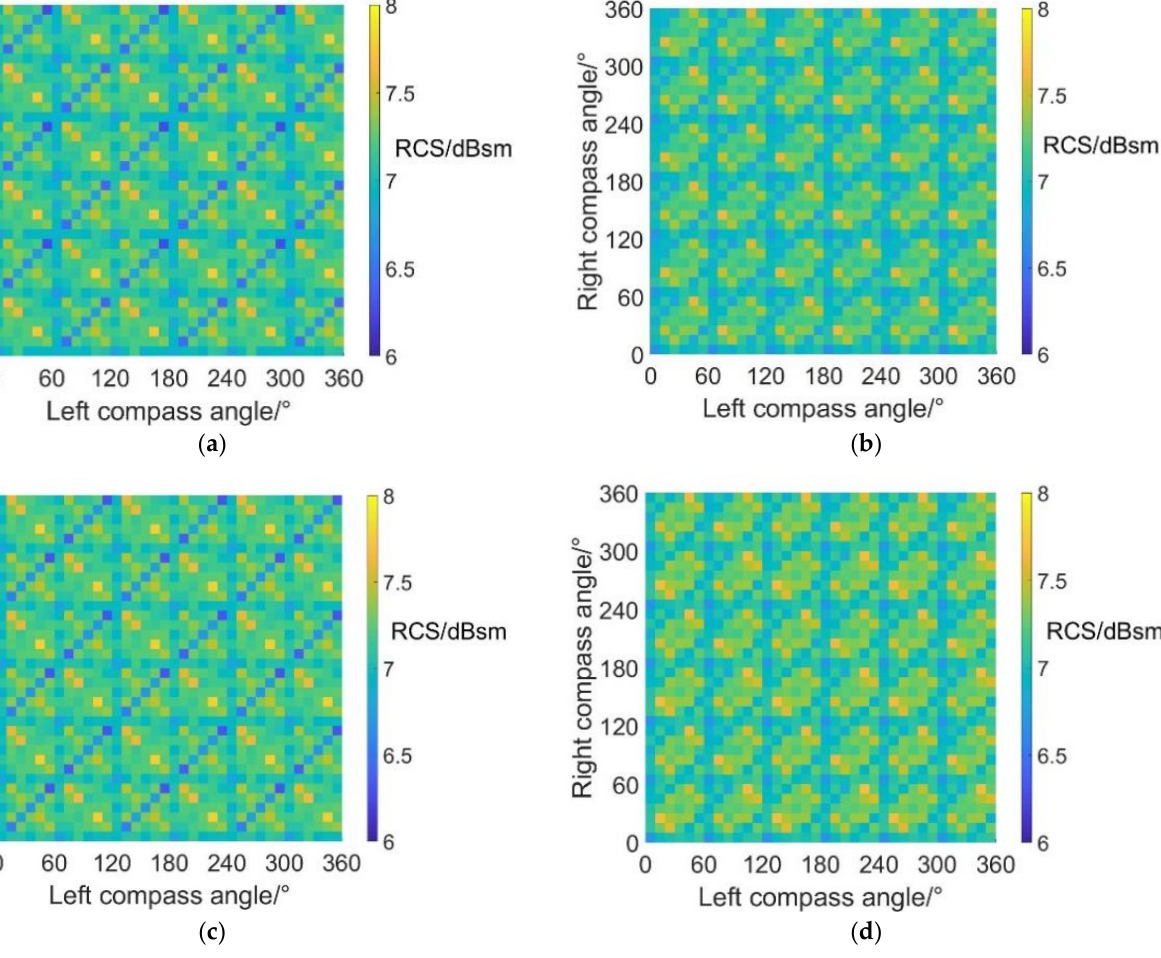
Figure 16. Carpet diagrams of average RCS in helicopter mode at an azimuth angle = 0° with scissors angle difference = ( a ) 0°, ( b ) 30°, ( c ) 60°, ( d ) 90°.